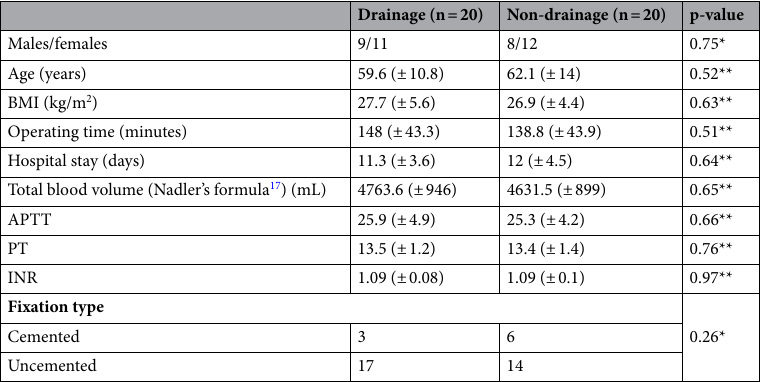
Table 2. Clinical and demographic data between the study groups. Continuous variables were presented as means (± SD). *Chi 2 Test (2 × 2). **Student T test. BMI Body Mass Index, APTT activated partial thromboplastin time, PT prothrombine time, INR international normalized